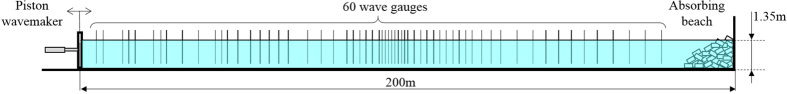
Schematic description of wave facility.